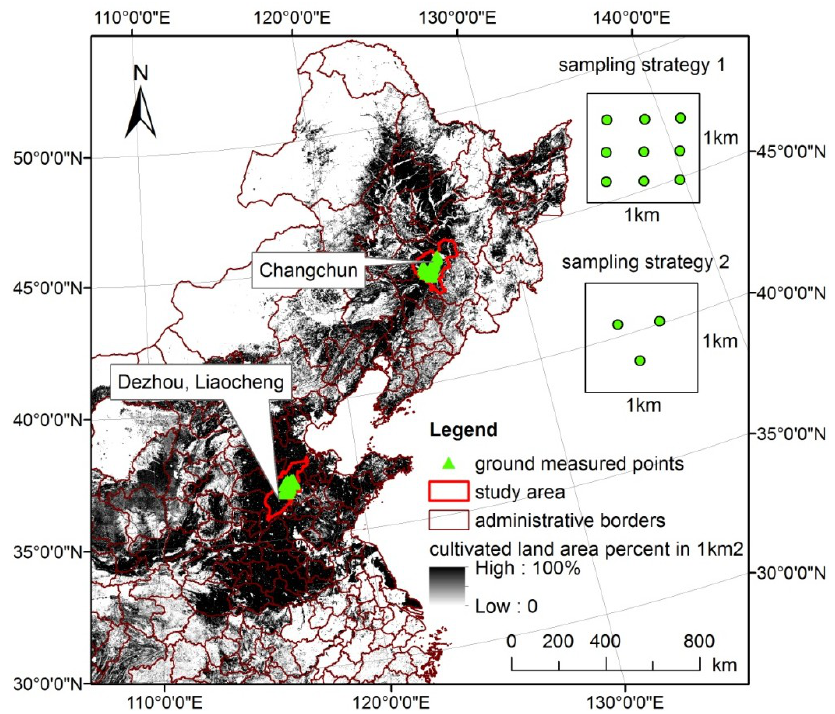
Figure 1. The cultivated land area in study area and fraction of photosynthetically active radiation (FPAR) ground measurements.